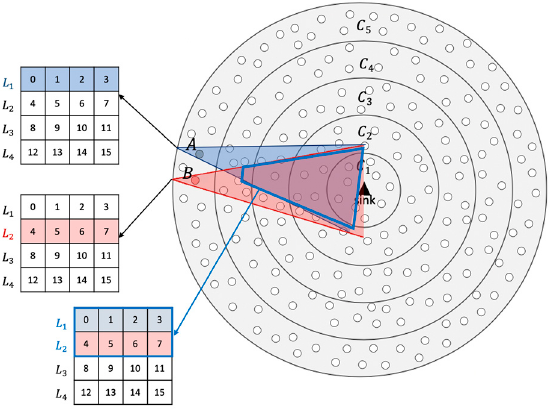
Figure 3. A five coronas network with an example of slots assignment for non-forwarder